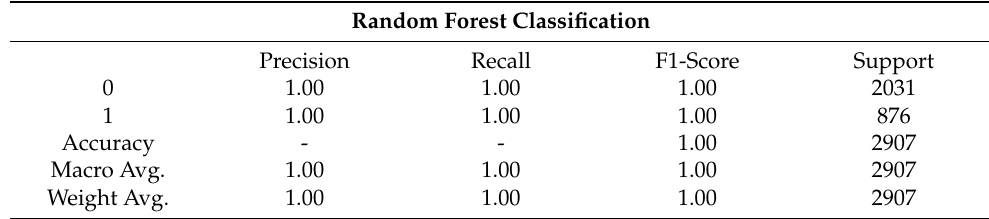
Table 1. Random forest classification